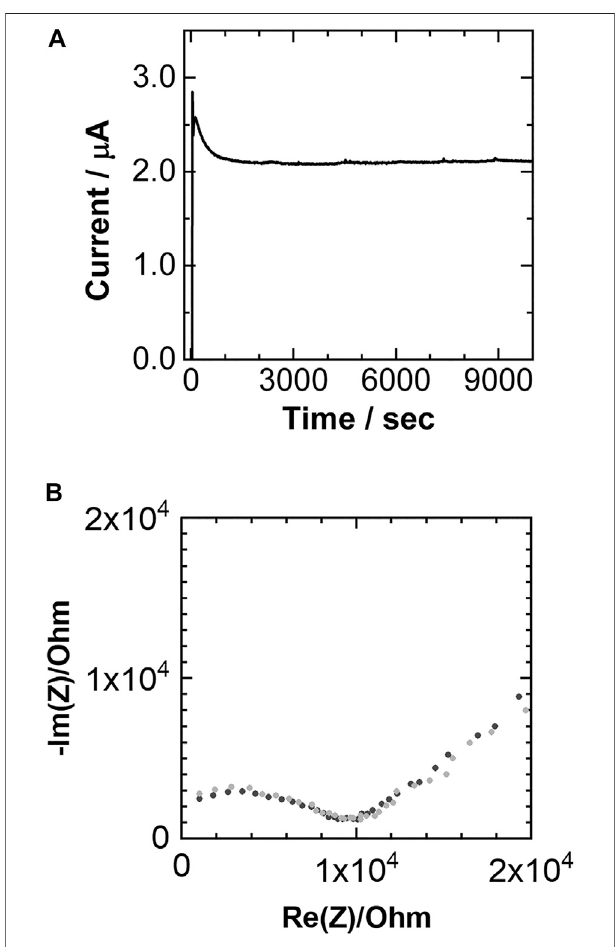
FIGURE7|(A) TimedependenceofcurrentwithDCpolarizationvoltage of 1.0 V for Mg|Mg(TFSA) 2 (CPME) 2 |Mg at 40 ° C for estimating the Mg-ion transferencenumber; (B) NyquistplotsofMg|Mg(TFSA) 2 (CPME) 2 |Mgat40 ° C; (black) taken before the DC polarization measurement (gray) taken after the current of the DC polarization reaches steady